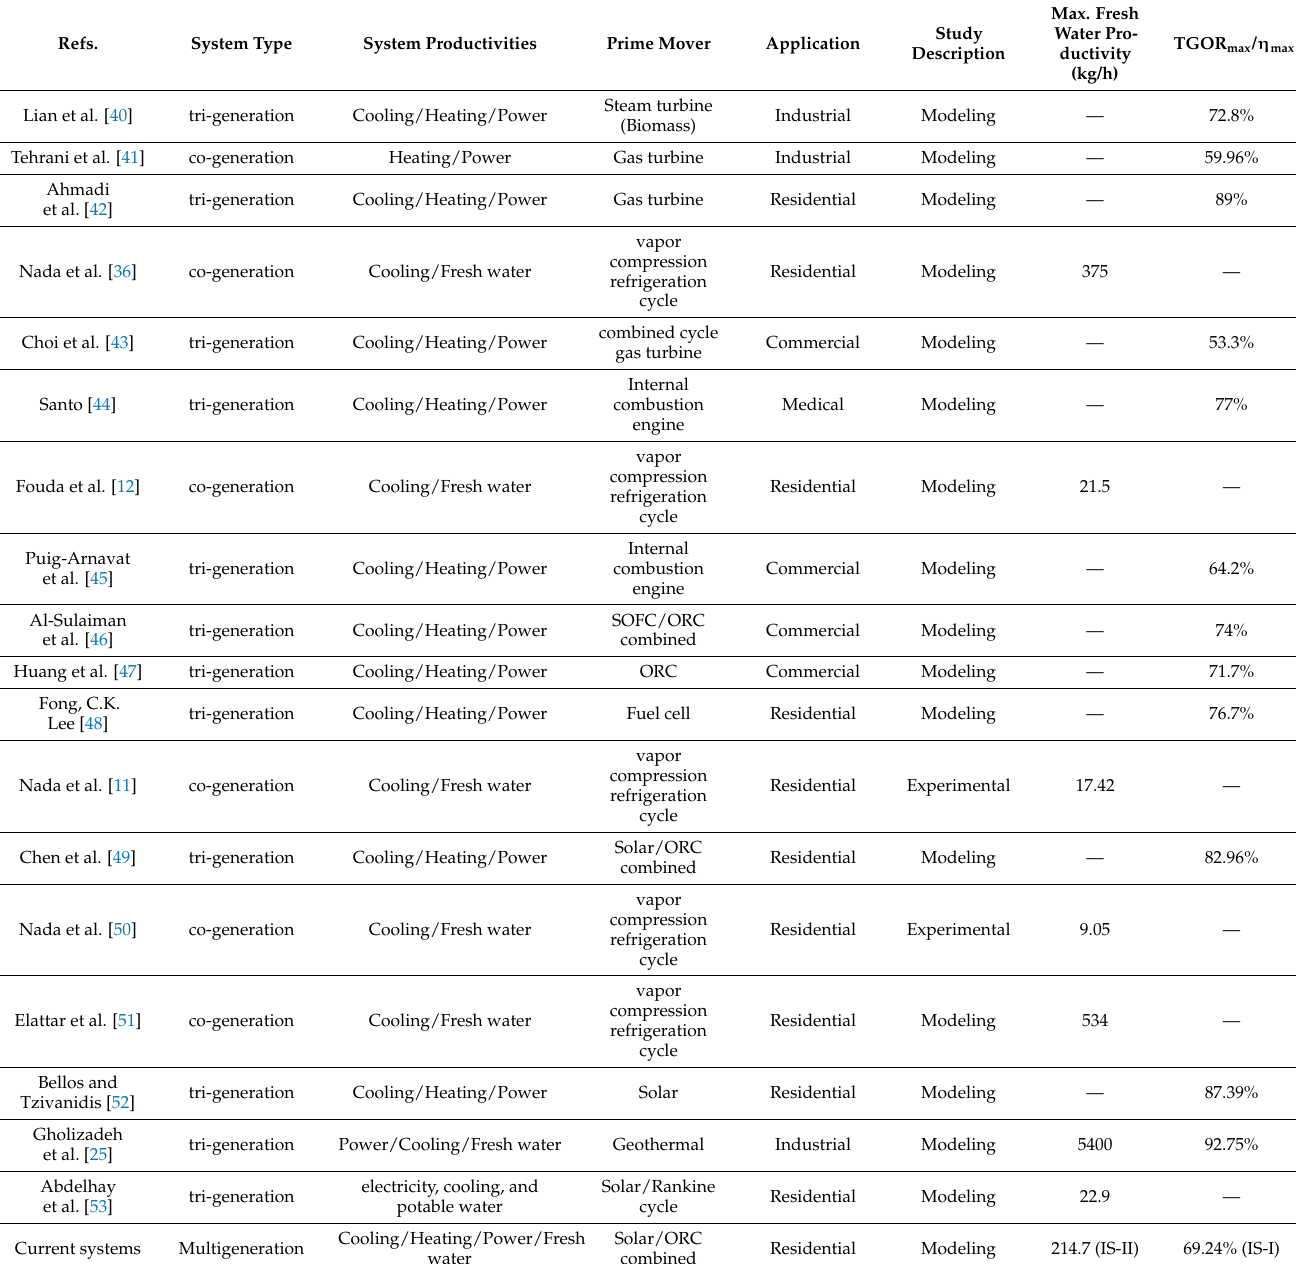
Table 5. Comparison of the current systems with other reported